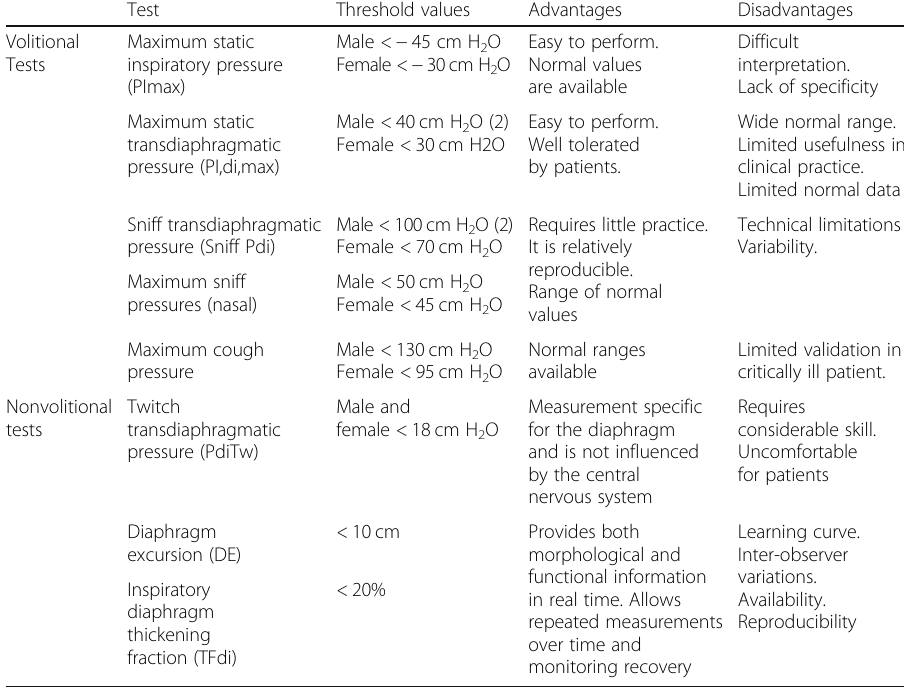
Table 1 Summary of the clinical tests used in the assessment of respiratory muscle strength [63] Test Threshold